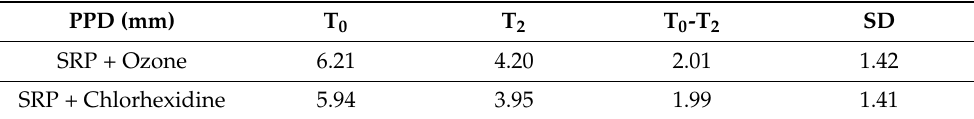
Table 4. Reduction of PPD in trial and control sites from baseline to the end of the